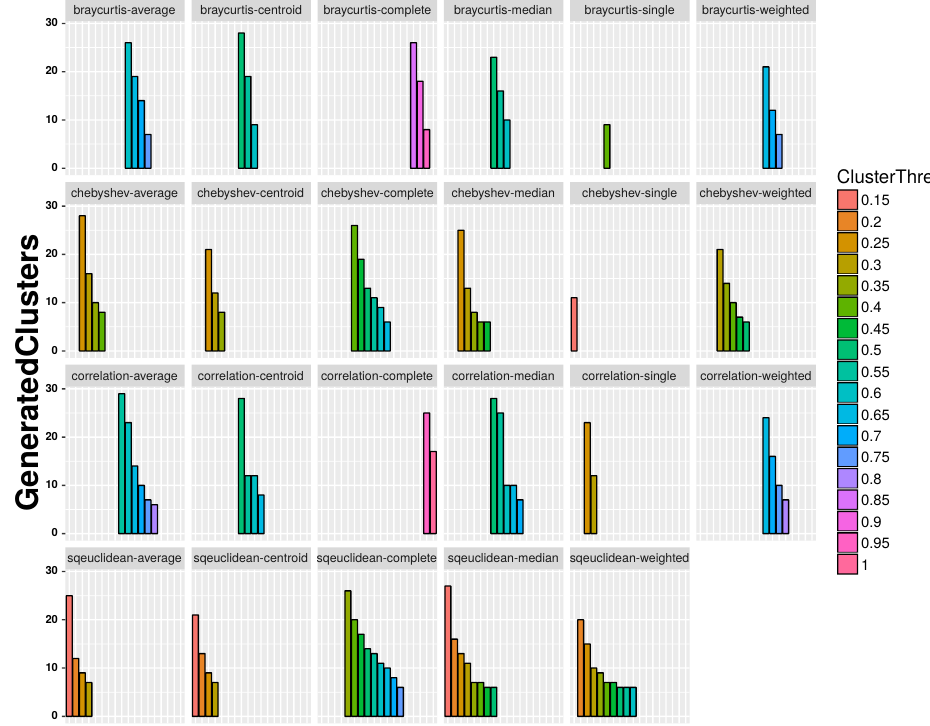
Figure 7. Each section of this chart shows the number of clusters generated by the combination of parameters in the algorithm, with every section representing a map. For each section, the x-axis indicates the threshold values used to cluster the map; each value is represented by a different color. The y-axis encodes the number of clusters generated by each